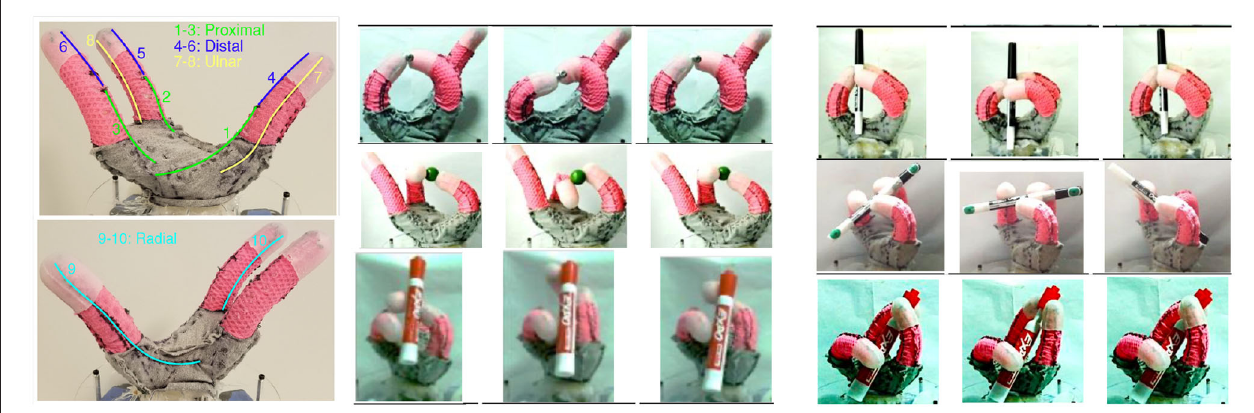
FIGURE 6 | Ten degree-of-freedom dexterous soft foam robot hand developed by Coulson (2020), along with some of manipulations it can perform. The technique described in this paper can be used to identify continuous families of manipulations centered around the actions shown in the future.